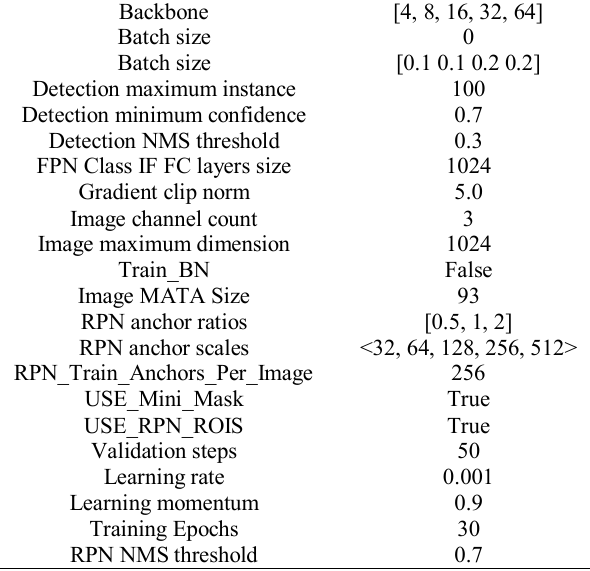
Table 1: Mask R-CNN Parameters